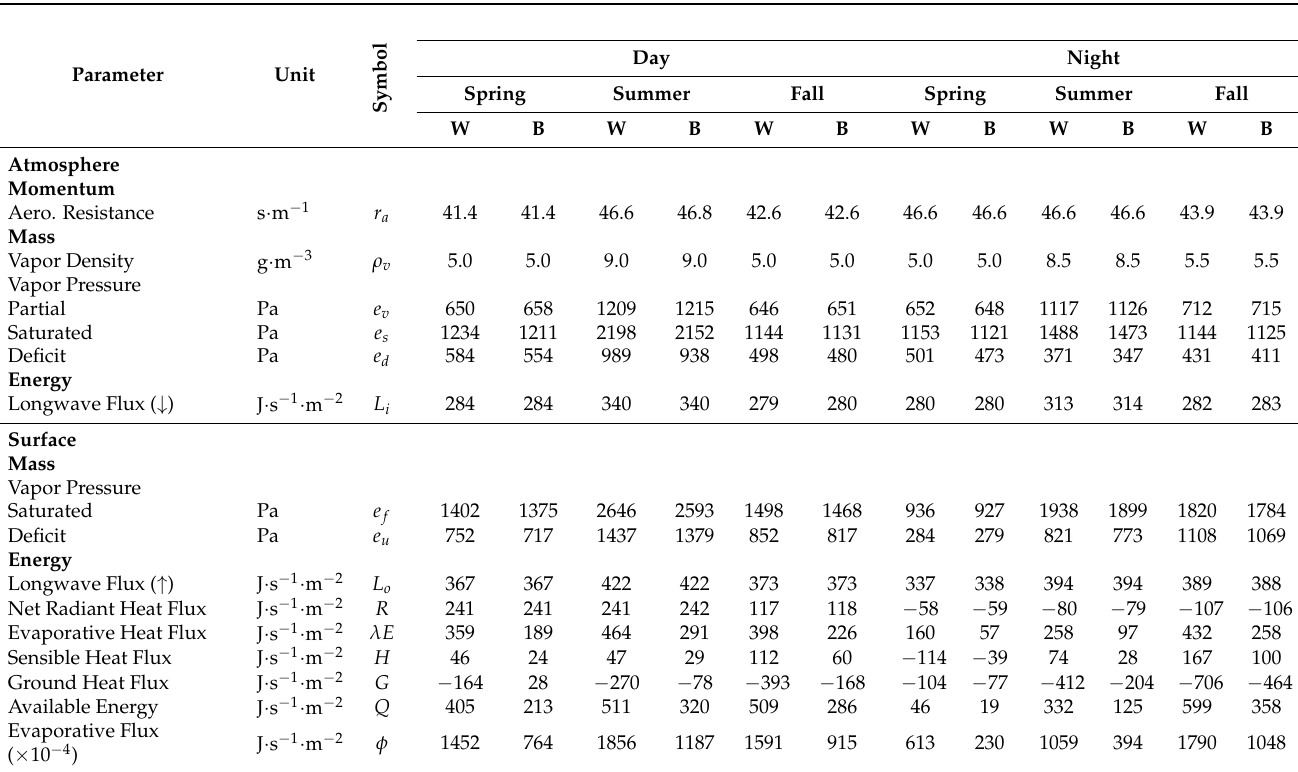
Table 3. Summary of the analyzed average atmospheric and surface